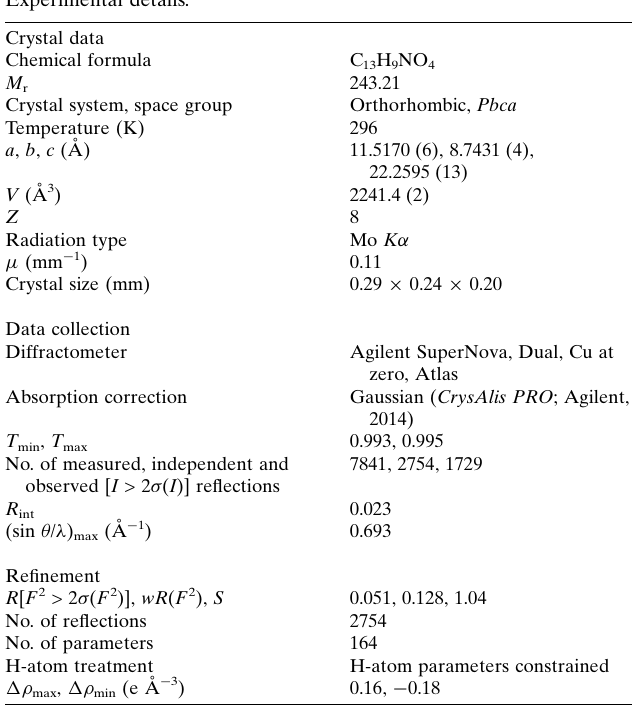
Table 2 Experimental details.